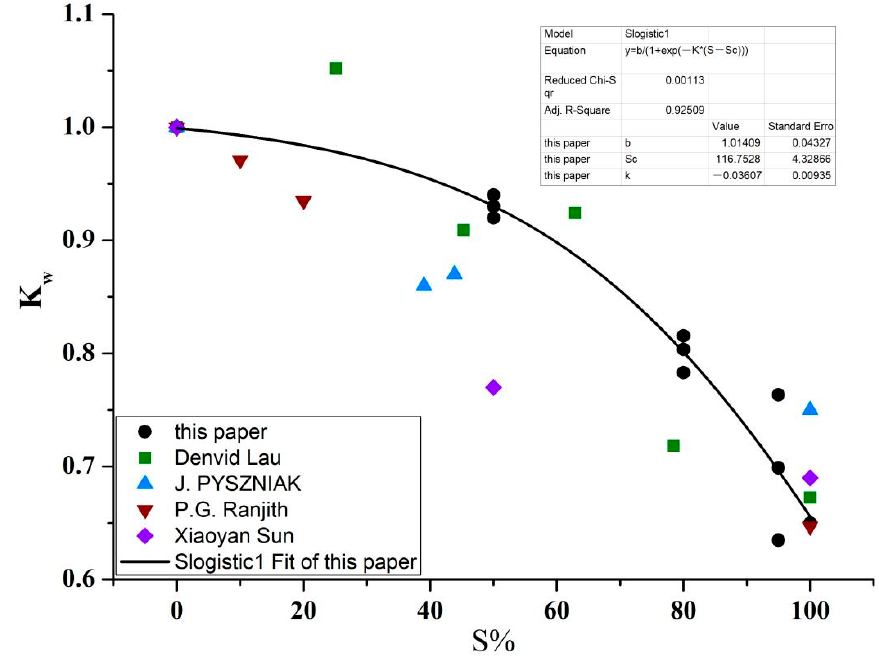
Figure 7. The relation between the water softening factor, K w , and the relative saturation ratio,